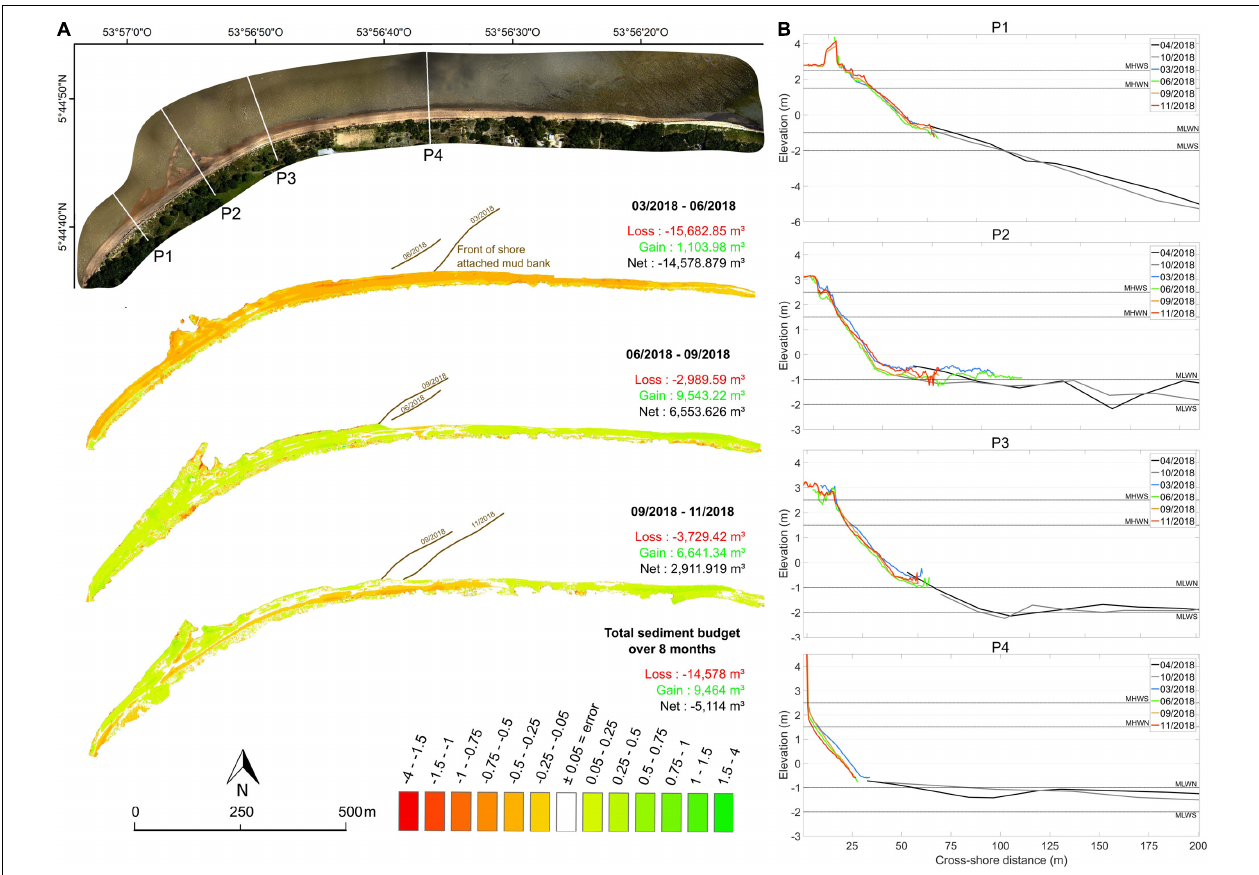
FIGURE 10 | High-density orthophotograph assemblage (March 2018) and three DoDs of the beach obtained from SfM photogrammetry in 2018, together with net budget estimations (A) , and examples of beach and shoreface profiles (B)